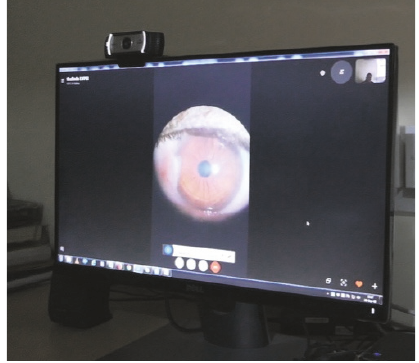
Figure 14: Command center receiving the